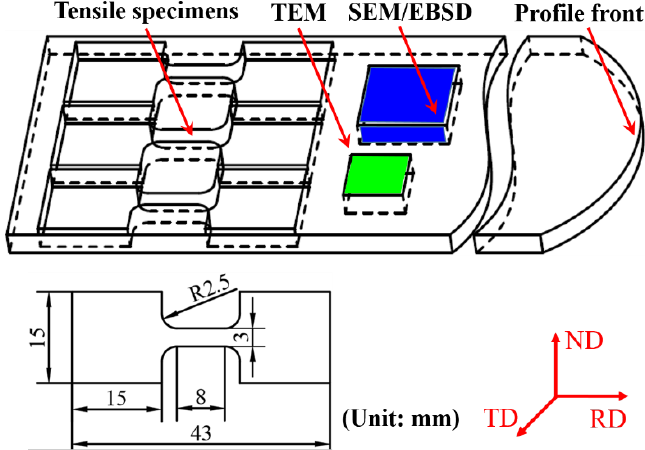
Figure 1. The sampling position and dimensions of tensile specimens.